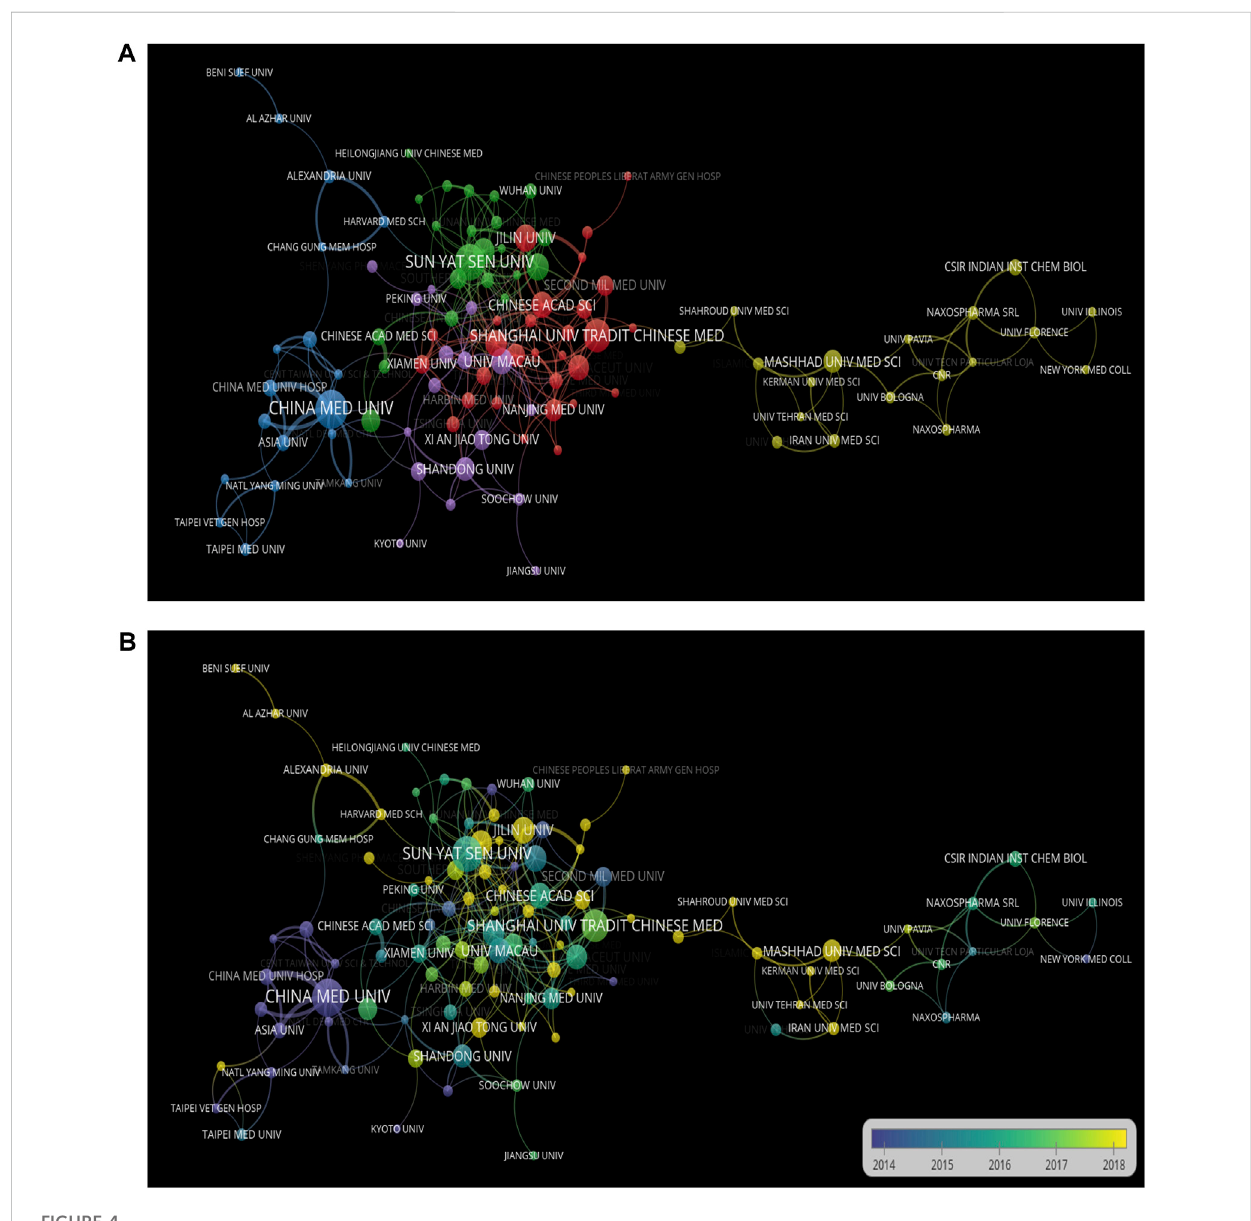
FIGURE 4 Cooperation networks between institutes based on VOSviewer. (A) Cooperative relationship of various institutions using network map. (B) Cooperative time of various institutions using network map.